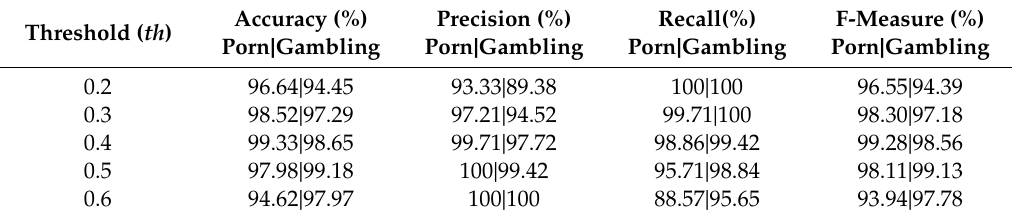
Table 9. Experimental results using di ff erent thresholds ( th ).